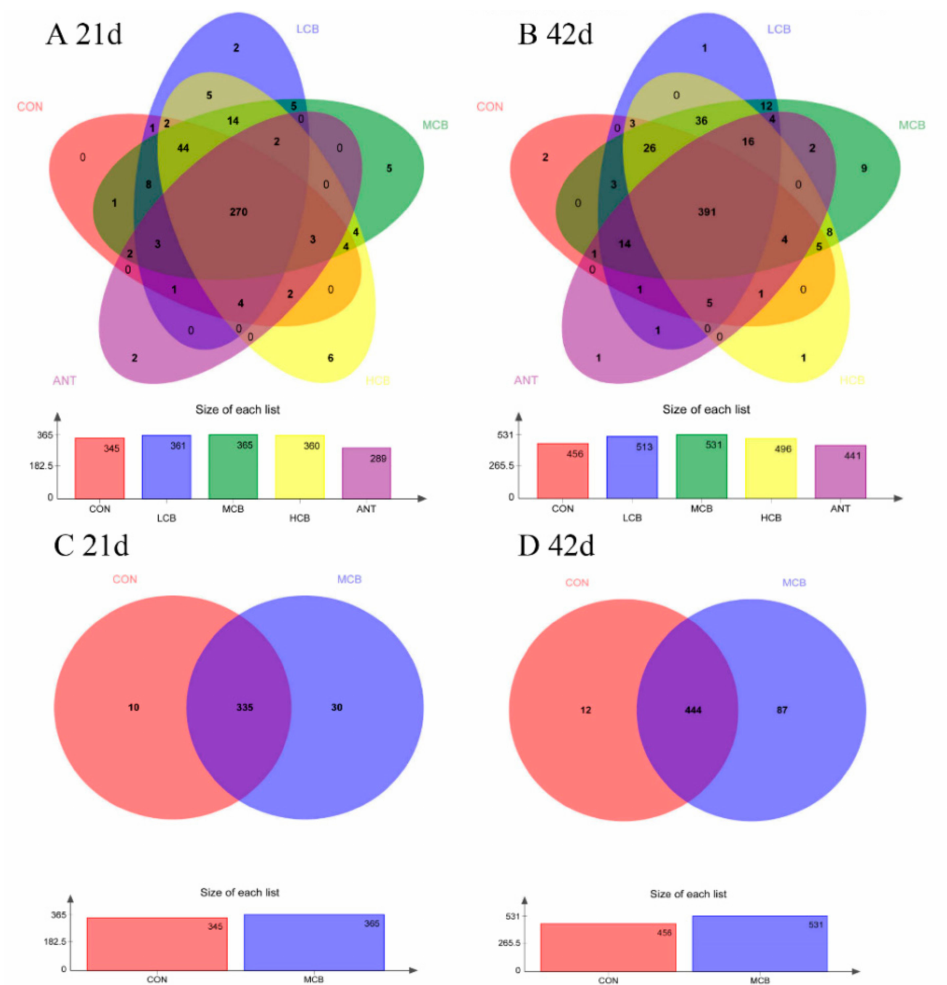
Figure 5. Venn diagram for intestinal microbiota of Pekin ducks (N = 5). Each circle represents a group of samples. The numbers of common bacterial operational taxonomic units (OTUs) are showed in the overlapping part between different circles, while the numbers in the non-overlapping part between different circles represent the number of their respectively unique OTUs in each group. ( A ), Venn diagram of five groups at 21 d; ( B ), Venn diagram of group A and group C at 21 d; ( C ), Venn diagram of five groups at 42 d; ( D ), Venn diagram of group A and group C at 42 d; CON, group Con; LCB, group CB200; MCB, group CB400; HCB, group CB600; ANT, group